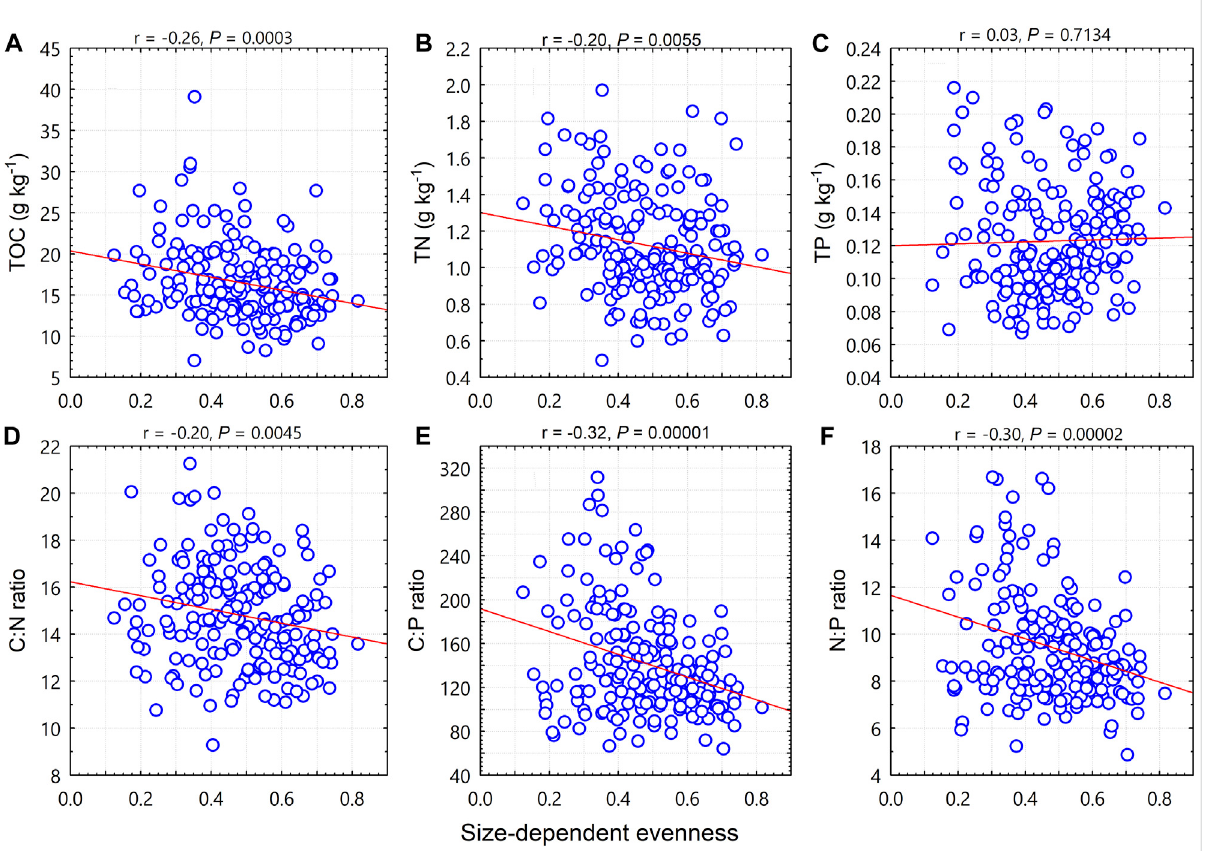
FIGURE 4 Relationships between woody plant size-dependent evenness and soil total organic carbon (TOC), total nitrogen (TN), total phosphorus (TP), and C:N:P stoichiometric